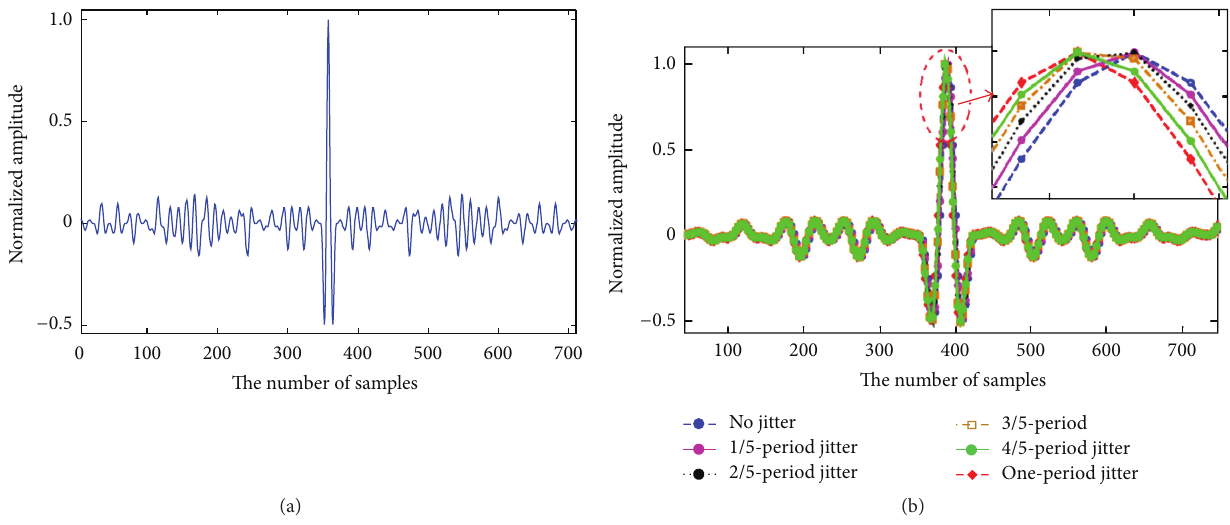
Figure 5: Cross-correlation of the 𝑚 -sequence with 31 chips in close-loop situation. (a) Cross-correlation of the sampled 𝑚 -sequence with 31 chips. (b) Cross-correlations of the sampled 𝑚 -sequence with unstable initial sampling time.